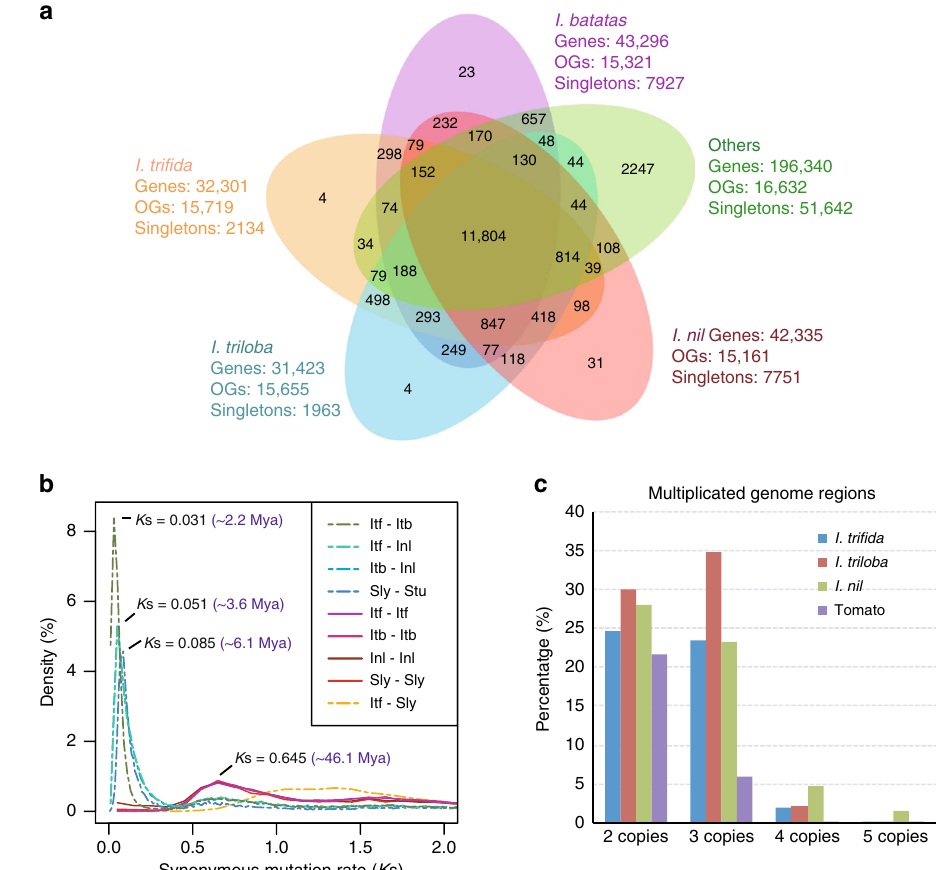
Fig. 2 Gene family clustering and Ipomoea whole-genome triplication. a Venn diagram of orthologous gene families. OGs, orthologous groups. ‘ Others ’ include tomato, potato, grapevine, Arabidopsis thaliana , rice and Amborella trichopoda . b Distribution of K s of orthologous or paralogous genes within and between genomes of I. tri fi da (Itf), I. triloba (Itb), I. nil (Inl), tomato (Sly) and potato (Stu). Estimated times of speciation and WGT events were calculated using a mutation rate of 7 × 10 − 9 substitutions per site per year. Mya, million years ago. c Multiplicated genomic regions in I. tri fi da , I. triloba , I. nil , and